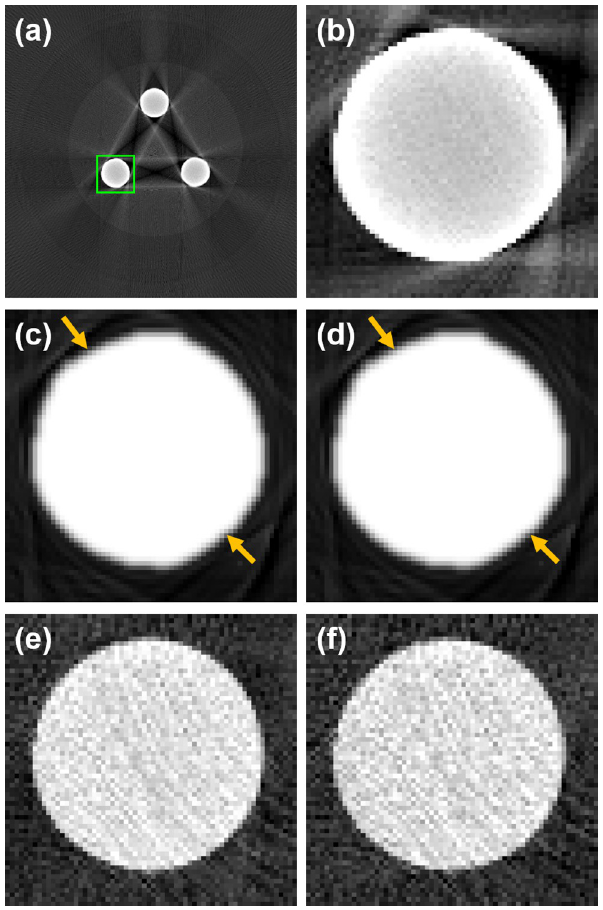
Fig 12. Enlarged CT images from the experimental results using the MAE phantom with the different MAR methods. (a) The ROI position for circularity calculations. (b) The uncorrected CT image with 140 kV polychromatic X-ray. (c) The corrected CT images obtained using the LMAR method. (d) The corrected CT images obtained using the NMAR method. (e) The projection-based VMCT image obtained using a polynomial method (VMI-poly) at 100 keV. (f) The projection-based VMCT image obtained using the MLE and LUT method (VMI-Atable) at 100 keV. Window width and level of the image display are 15,000 HU and 6,500 HU, respectively.